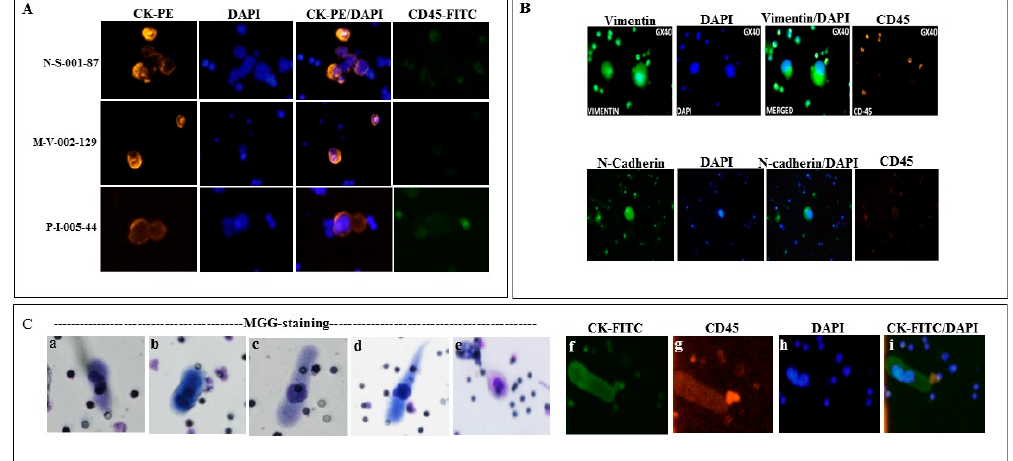
Figure 1. Detection of circulating cancer associated cells in metastatic breast cancer (MBC): ( A ) Representative immunostaining images from three patient samples with identifications (N-S-001-87, M-V-002-129, P-I-005-44) showing circulating tumor cells (CTCs) and CTC clusters with cytokeratin (CK) and 4 ′ ,6-diamidino-2-phenylindole (DAPI) positive and CD45 negative staining; ( B ) Immunostaining of epithelial–mesenchymal transition (EMT) CTCs showed mesenchymal markers Vimentin or N -Cadherin positive; ( C ) Representative images of cancer associated macrophage-like cells (CAMLs) from MGG (May-Grunwald Giemsa) and immunostaining, cytological phenotypes as: spindle-shaped ( a , d ); round ( b , e ); oblong ( c ); cytokeratin positive ( f ); CD45 positive ( g ); DAPI ( h ); and composite image of CK and DAPI ( i ). The images were acquired on microscope at 40× magnification.